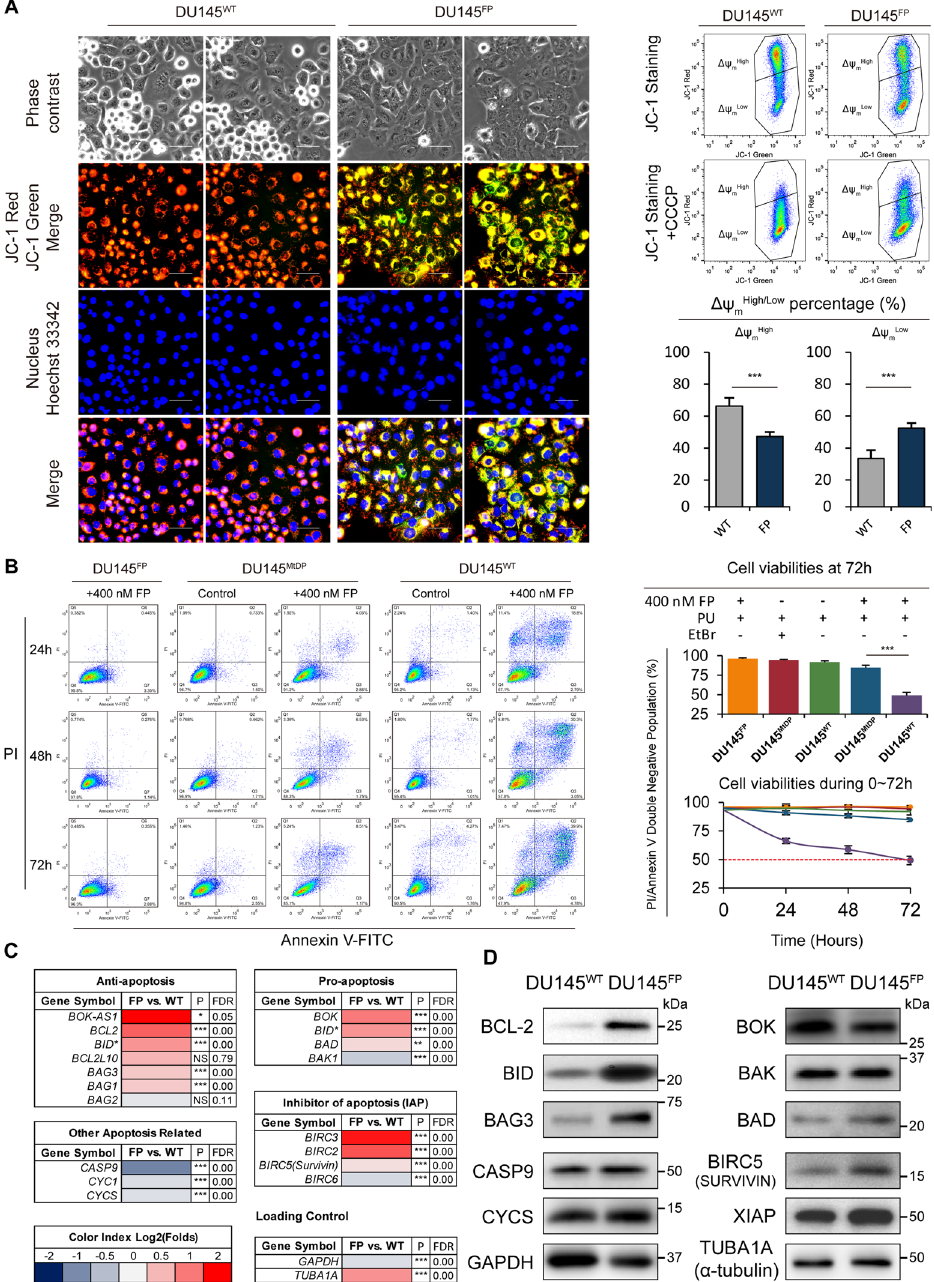
Figure 2. FP-induced DU145 cell death is mitochondria-dependent, and the DU145 FP cells express higher levels of anti-apoptotic factors. ( A ) Left: mitochondrial membrane potential is presented by JC-1 probe excitation status. The red signals denote mitochondrial Δψ mHigh features, whereas green signals denote mitochondrial Δψ mLow features. The abbreviation Ph stands for phase contrast, and the scale bars represent 100 µ m. Right: Flow cytometry analyses of Δψ m . The cells are stained with JC-1, and CCCP controls were used to confirm that the JC-1 response is sensitive to changes in membrane potential. Based on the high and low Δψ m status, the accordant cell proportions are summarized and shown in the histograms below. The data is presented as means from three independent experiments (mean ± S.D). ( B ) The DU145 FP , DU145 MtDP and DU145 WT cells were maintained in corresponding media with or without 400 nM FP for 24–72 hours. The cells’ double negative for both Annexin V-FITC and PI signal are considered as viable. The cell viability is presented in histograms and line charts. The data is presented as means from three independent experiments (mean ± S.D). ( C ) Transcriptome analyses of anti-apoptosis and pro-apoptosis genes. The Log 2 transformed ratio of FPKM values (e.g., FP/WT) are indicated by color-coded index bars. ( D ) The expression levels of apoptosis-associated proteins were detected by immunoblotting. Statistical significance: * p < 0.05, ** p < 0.01, *** p <